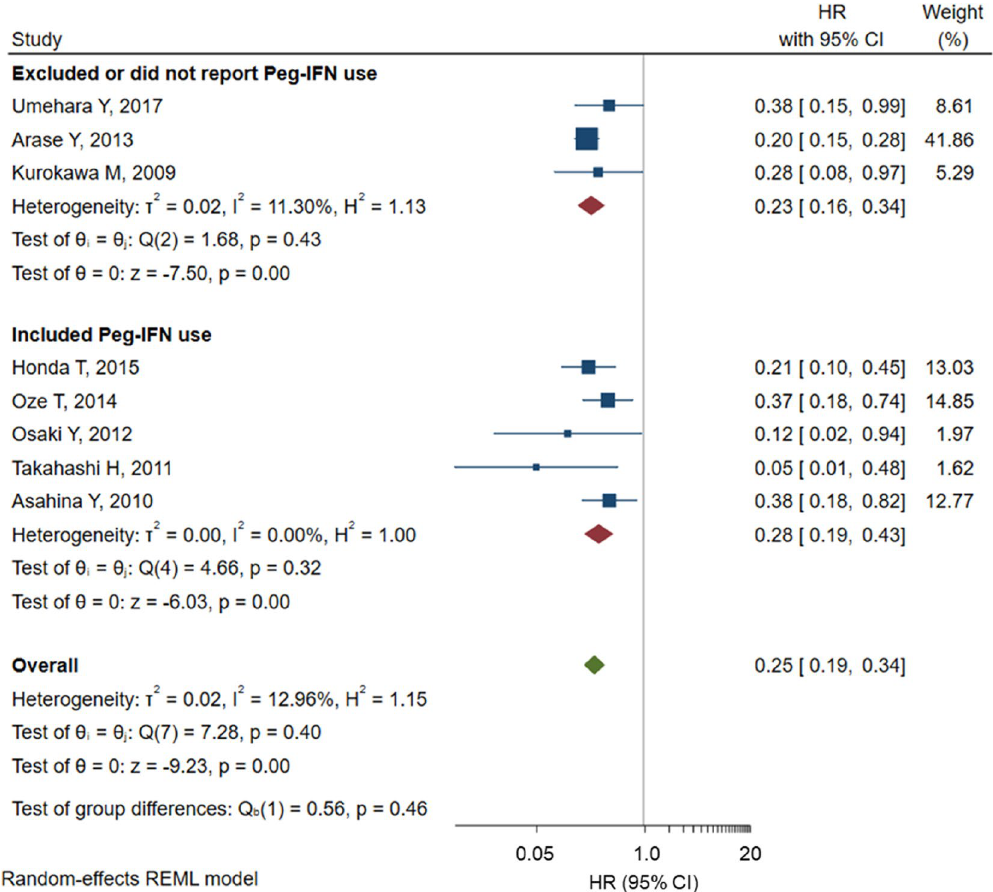
Figure 4. Forrest plot of the pooled estimate of the hazard ratio of HCC incidence adjusted for potential covariates in patients treated with antiviral therapy (SVR vs . non-SVR) by studies that did and did not include Peg-IFN use. HCC hepatocellular carcinoma, SVR sustained virologic response, Peg-IFN pegylated interferon, HR hazard ratio, CI confidence